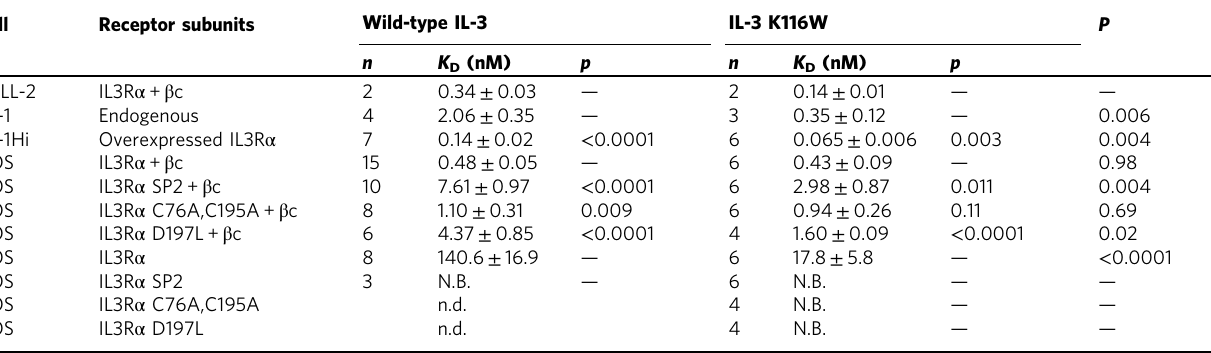
Table 2 Enhanced site 1a interactions do not fully compensate for the loss of site 1b binding interactions through the NTD